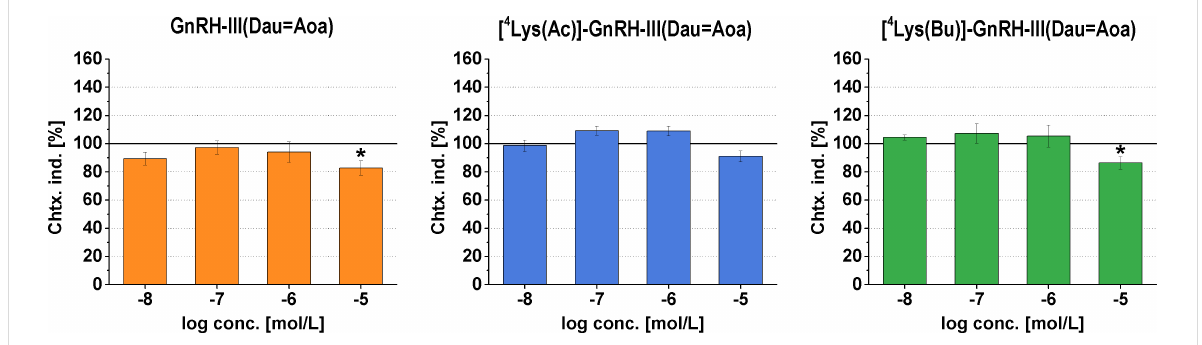
Figure 6: Chemotactic effects of Dau–GnRH-III conjugates on A2058 cell line. The ‘Chemotaxis index’ (Chtx. ind.) is expressed as a percentage of the control. Dau: daunorubicin. Data shown in the figures represent averages calculated for 8 parallels ± SD values. The level of significance is shown as *: p <